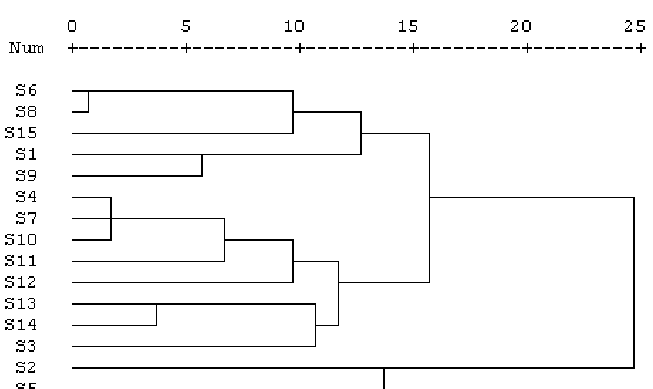
Figure 6. Results of cluster analysis of 15 samples.